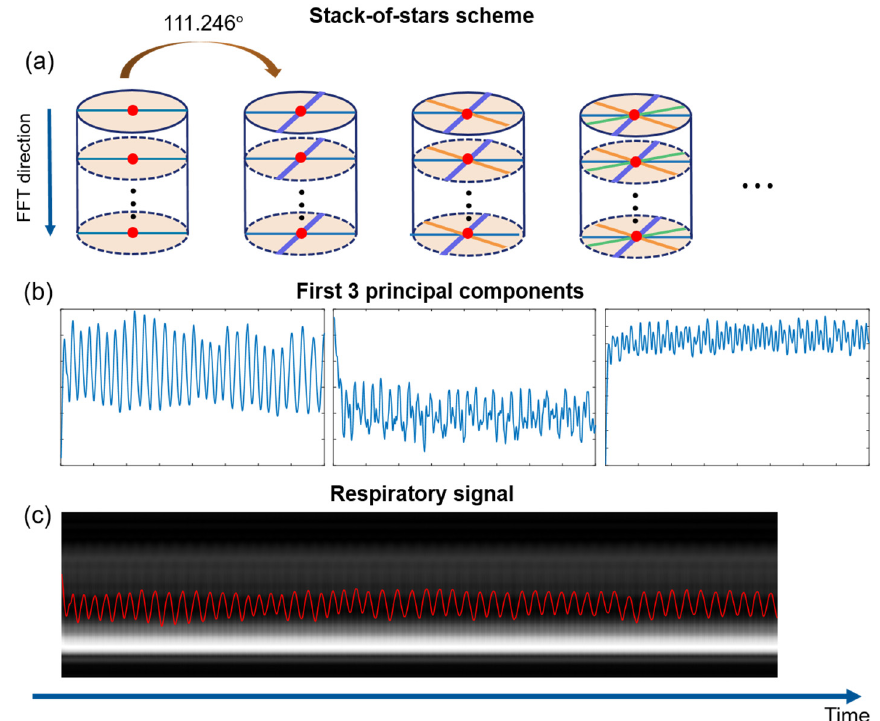
Figure 2. Respiratory motion extraction method. ( a ) 3D stack-of-stars acquisition scheme with gold angle (111.246 ◦ ) rotation. One dimension Fourier transform along kz direction was conducted on the center point of each spoke (red points), generating projection profile (shown in ( c )). ( b ) First three principal components were extracted from projection profile by PCA algorithm. ( c ) The first component was selected as respiratory signal superimposed on the corresponding projection profile.